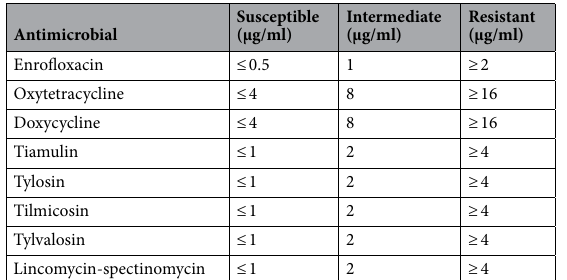
Table 1. MIC breakpoints of the eight tested antimicrobials 5,11,29,30 .